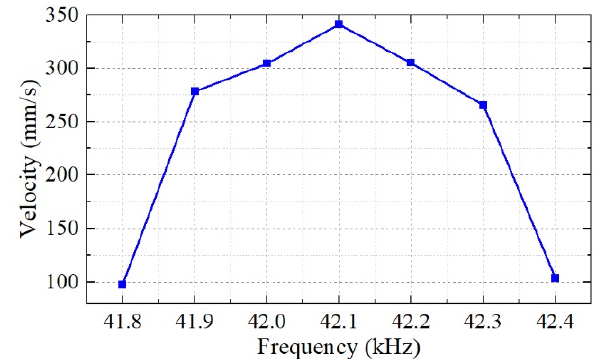
Figure 8. The output velocity versus the input excitation voltage frequency. The output velocity versus the input excitation voltage amplitude is shown in Figure 9, which indicates that we can change the voltage amplitude to increase the output veloc- ity. With the excitation voltage no more than 120 V, the mover cannot be driven. The max- imum velocity was approximately 340 mm/s under an excitation voltage of 300 V and 42.1 kHz.